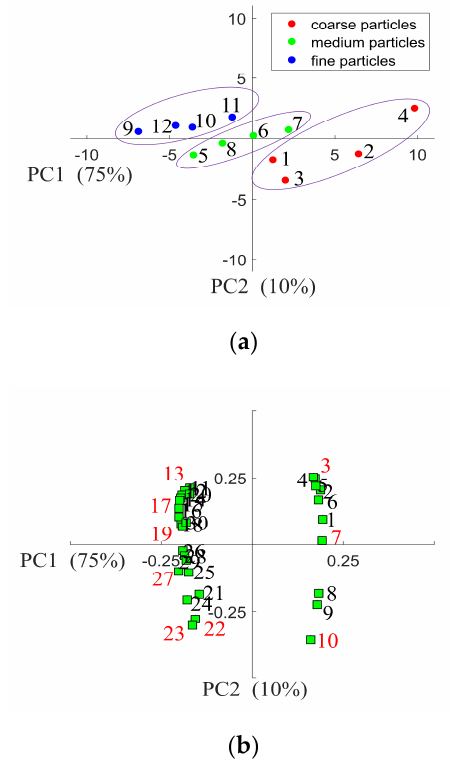
Figure 11. ( a ) PCA scores plot of the first two principal components allowing the discrimination of the twelve instant whole milk powder samples from their bulk density; ( b ) PCA loadings plot of the first two principal components allowing the determination of the relationships between different shape factor